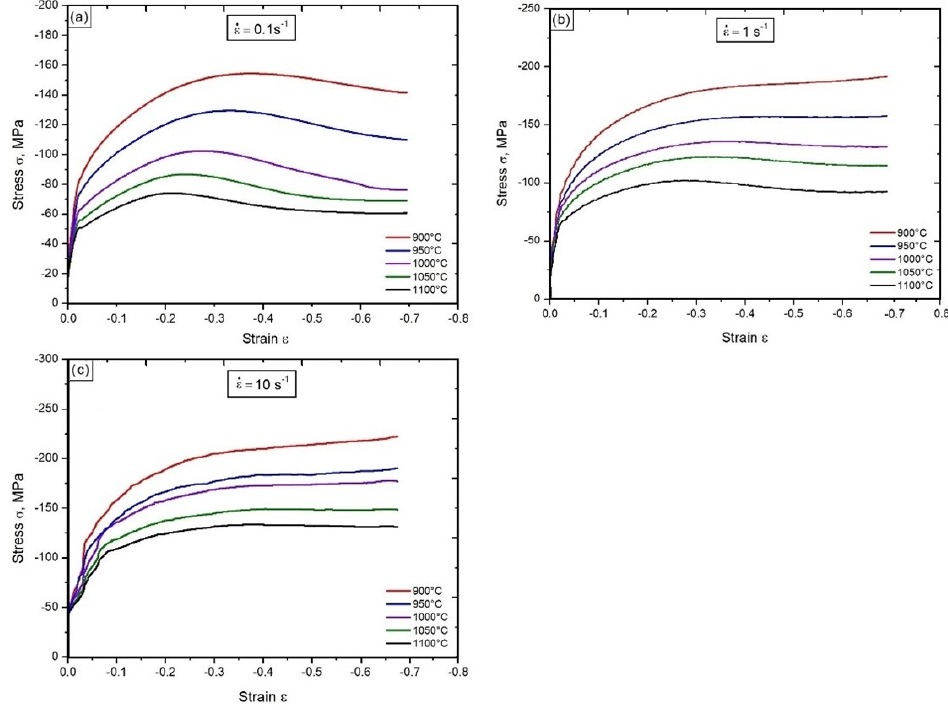
Figure 2. Impact of temperature and strain rate on the course of the σ – ε curves: 0.1 s − 1 ( a ), 1 s − 1 ( b ), 10 s − 1 ( c ).